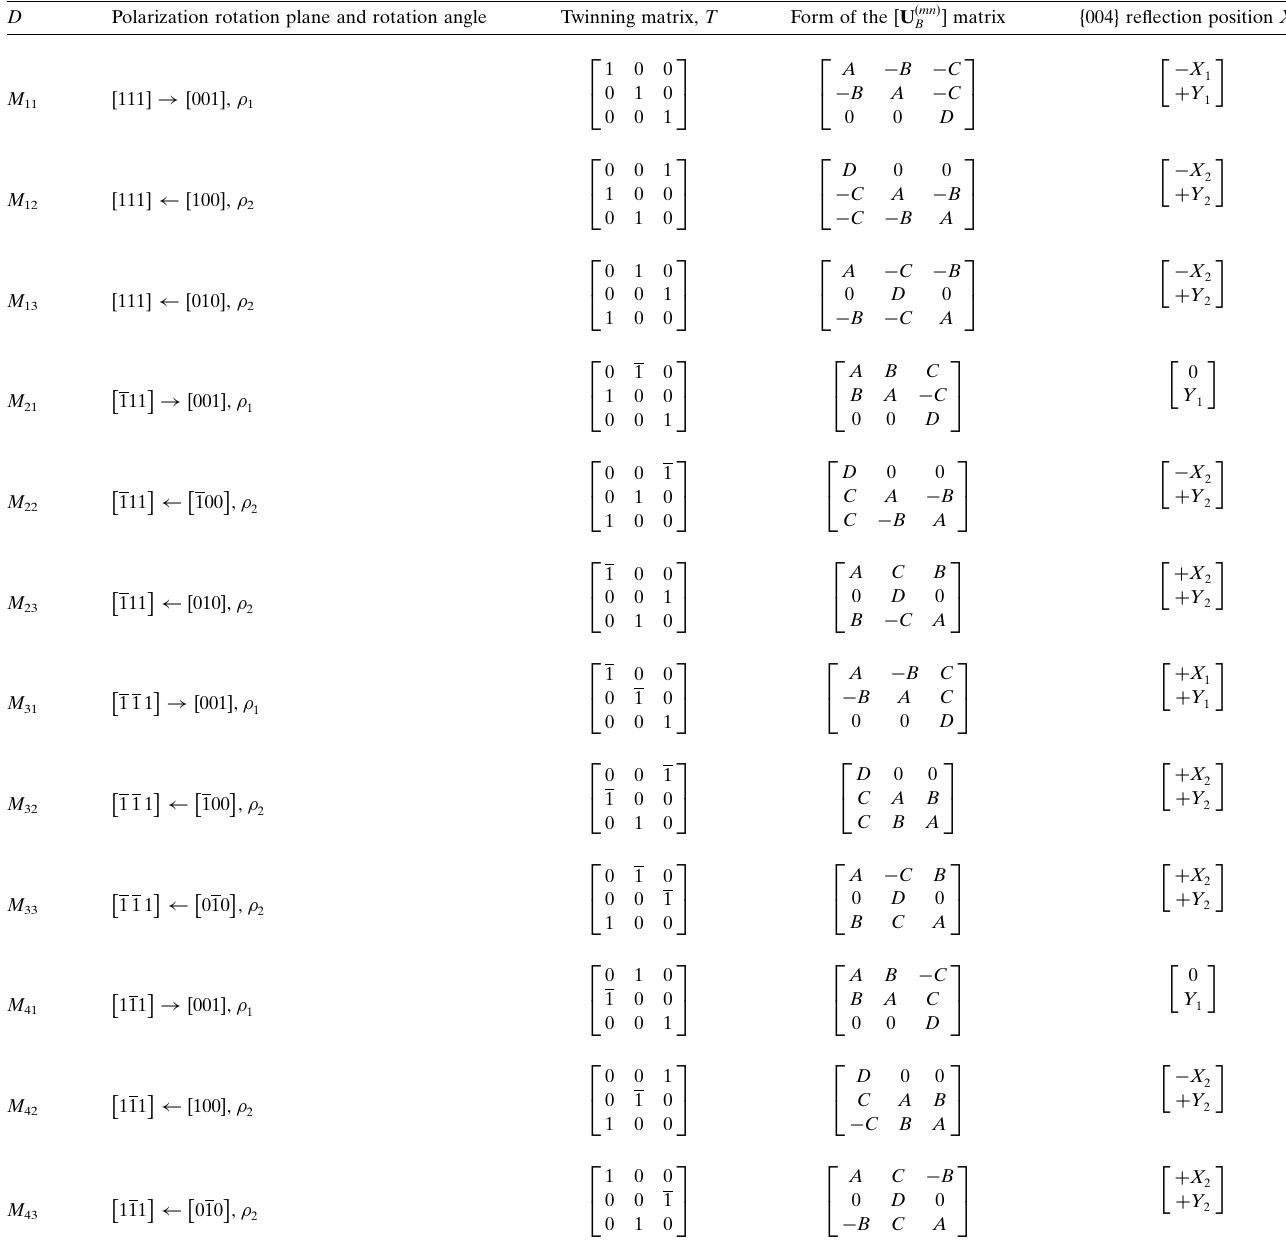
Table 1 Summary of the twinning matrices for all 12 monoclinic domains and the form of the reciprocal orientation matrices. Arrows indicate the polarization rotation direction induced by an [001]-oriented electric field. D Polarization rotation plane and rotation angle Twinning matrix, T Form of the ½ U ð mn Þ